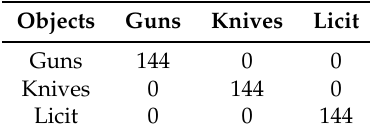
Table 5. Confusion matrix of licit/non licit object classification.